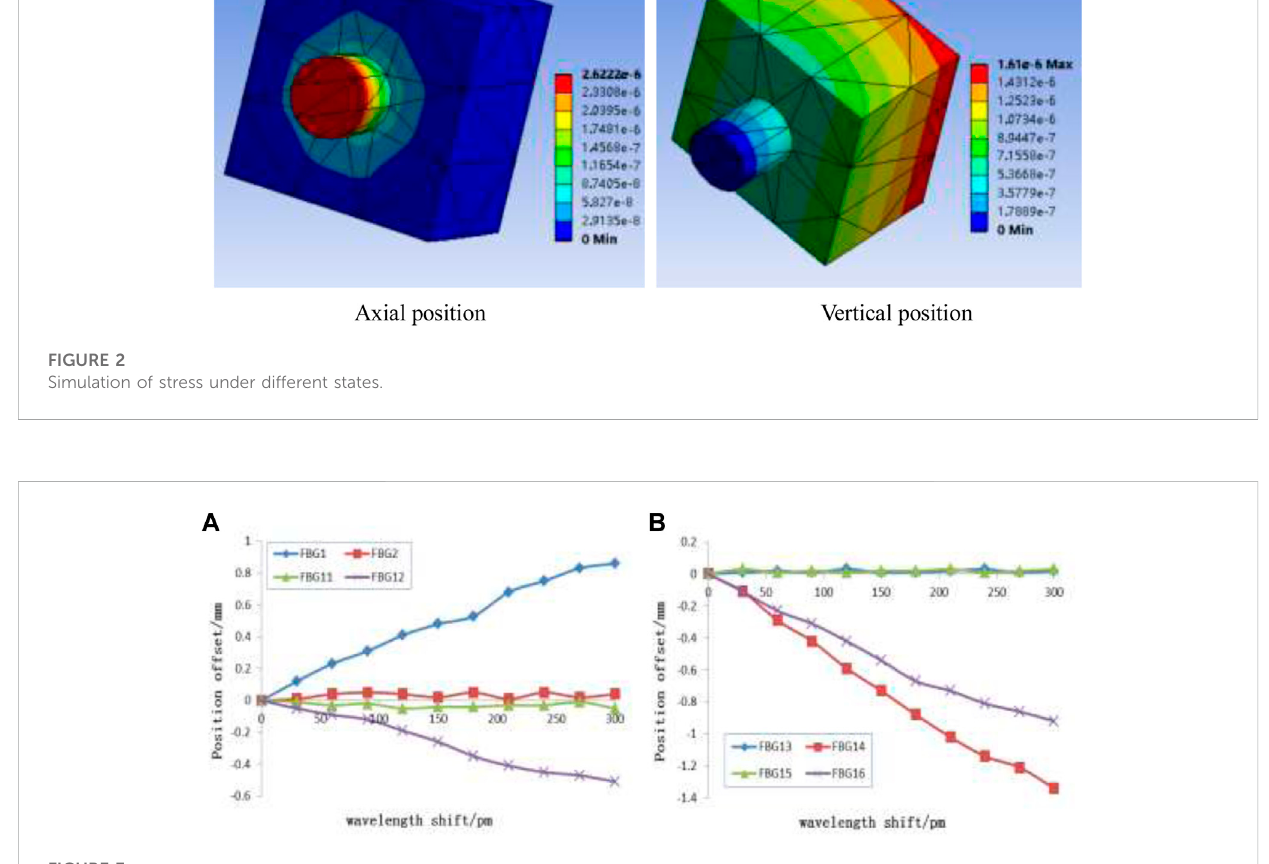
FIGURE 3 Wavelength offset values at different